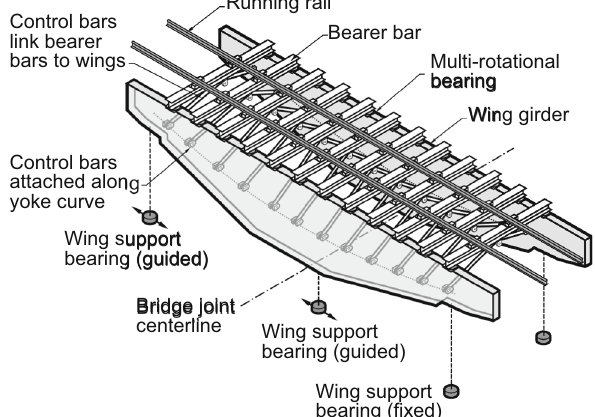
Fig. 10 CESuRa system in the vertical